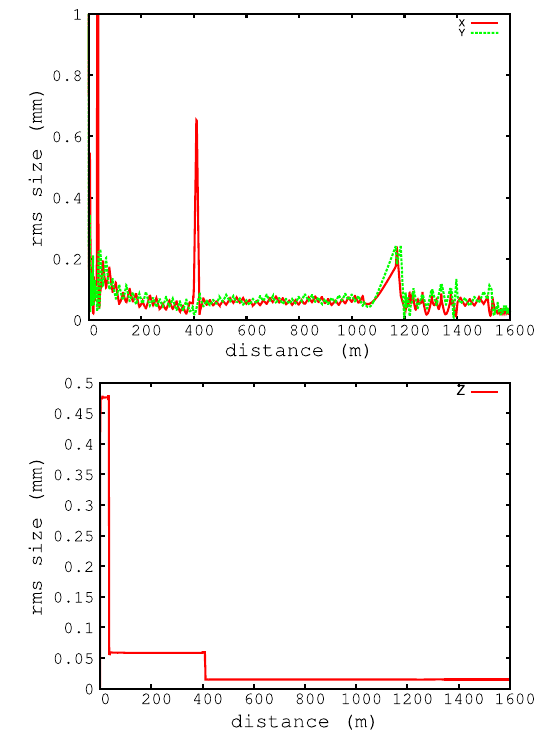
FIG. 3. Transverse rms size (top) and rms bunch length (bottom) evolution through the